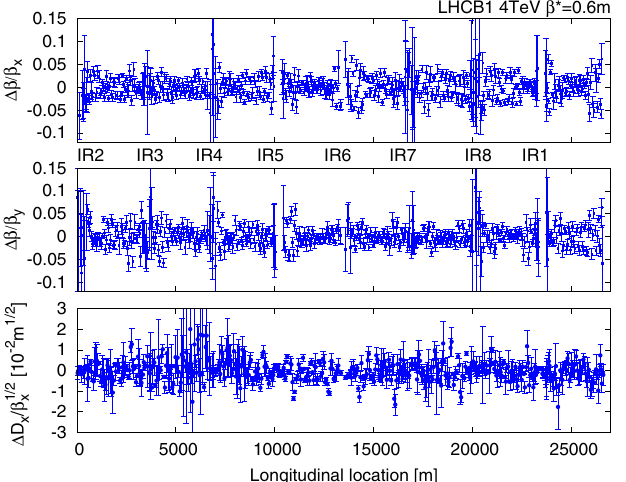
FIG. 7. Beam 1 (cid:1) beating and normalized dispersion beating after global correction at (cid:1) (cid:1) ¼ 0 : 6 m .